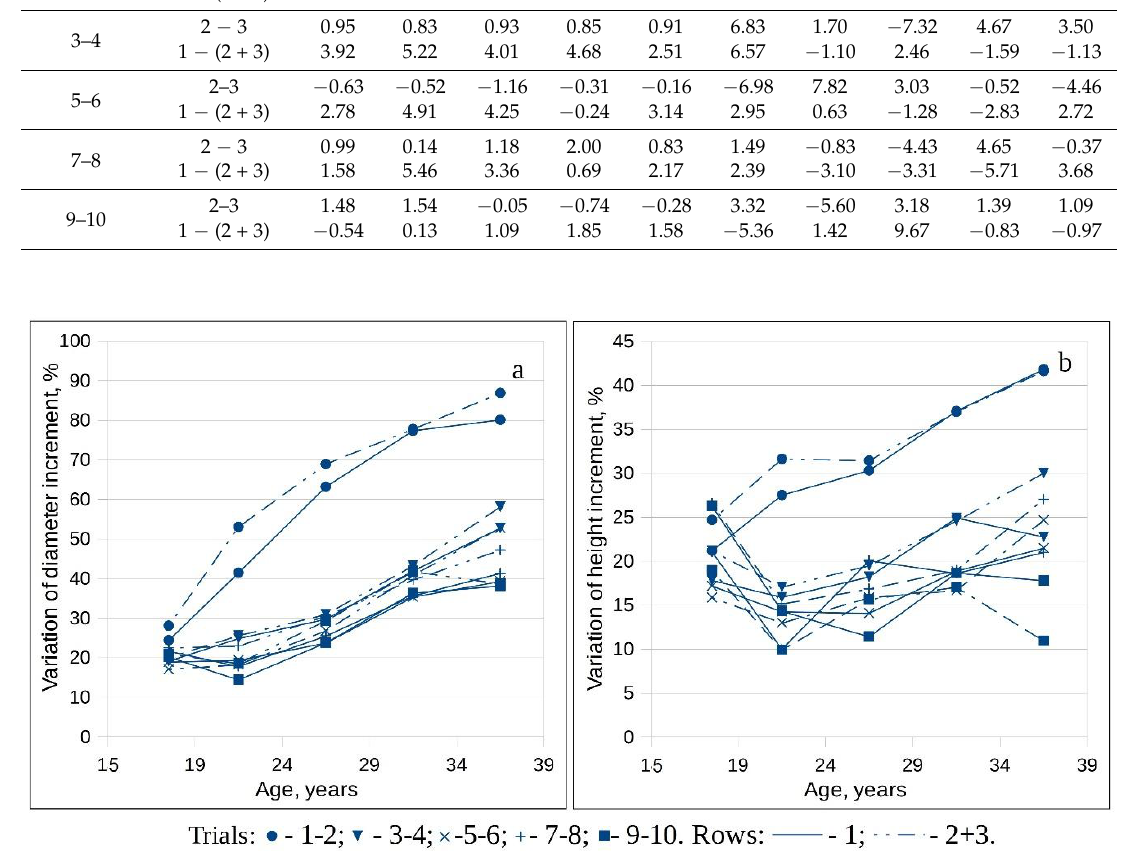
Figure 3. Changes of diameter ( a ) and height ( b ) increment variation based on age, density of growth (trials) and position of tree rows in relation to strip road.